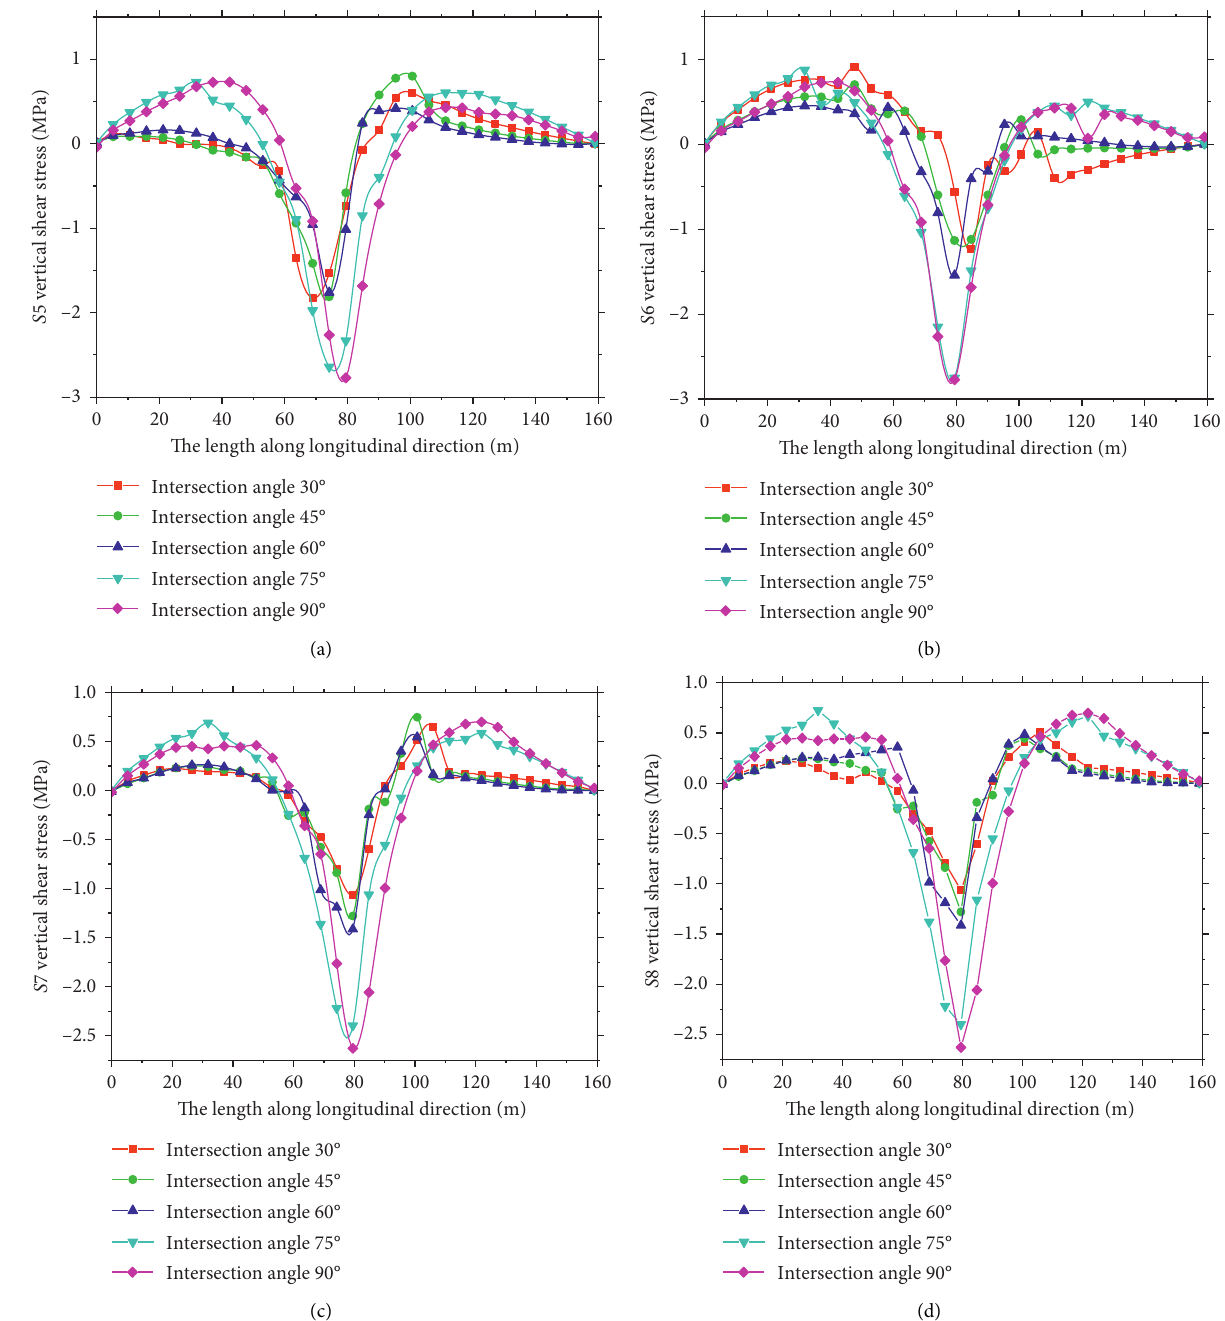
Figure 11: Vertical stress with different intersection angle. (a) The vertical stress of surveying line 5. (b) The vertical stress of surveying line 6. (c) The vertical stress of surveying line 7. (d) The vertical stress of surveying line